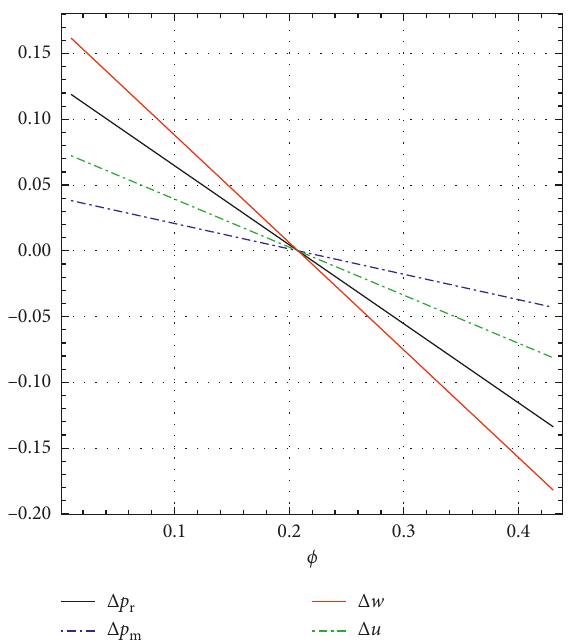
Figure 1: Comparison of steady-state decisions with ϕ .